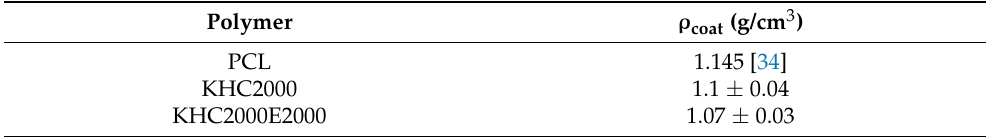
Table 1. Density of the polymers, ρ coat .